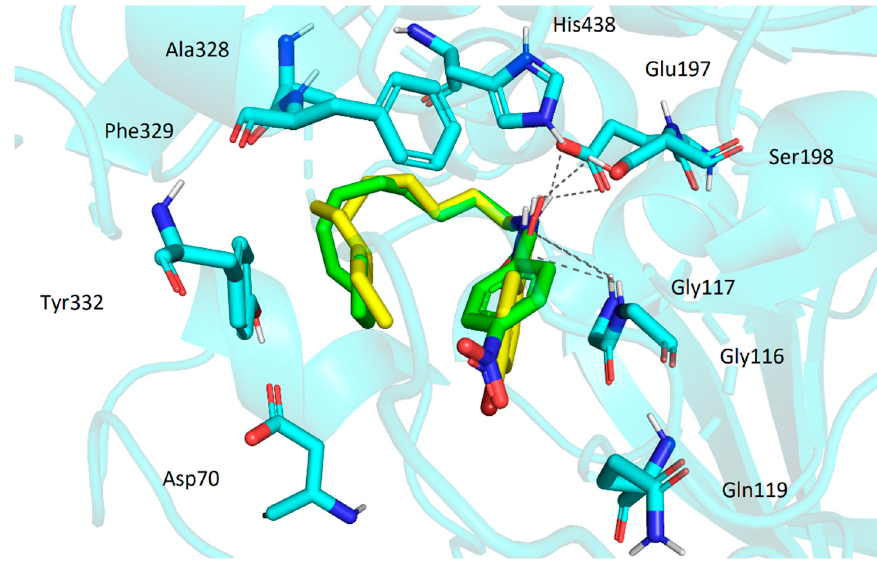
Figure 3. Conformation of compounds 1h (yellow) and 1l (green) in BChE.